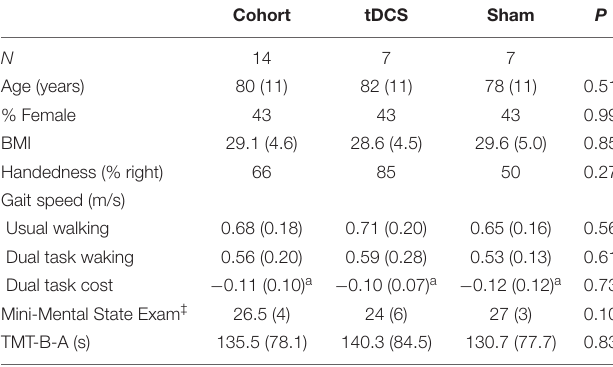
TABLE 1 | Baseline demographic characteristics by cohort and group (tDCS vs.